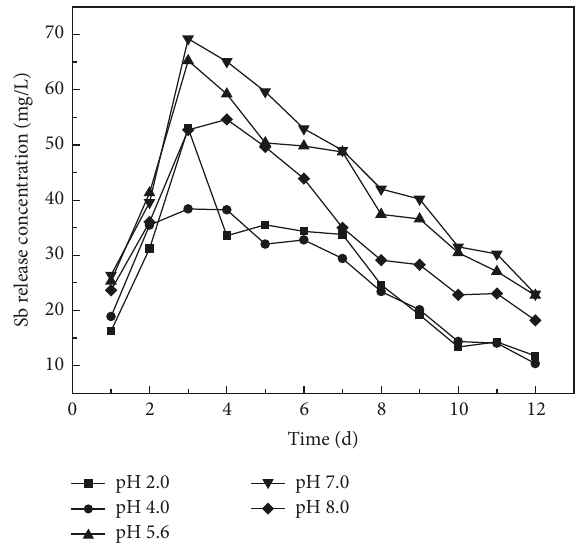
Figure 6: Sb concentration in